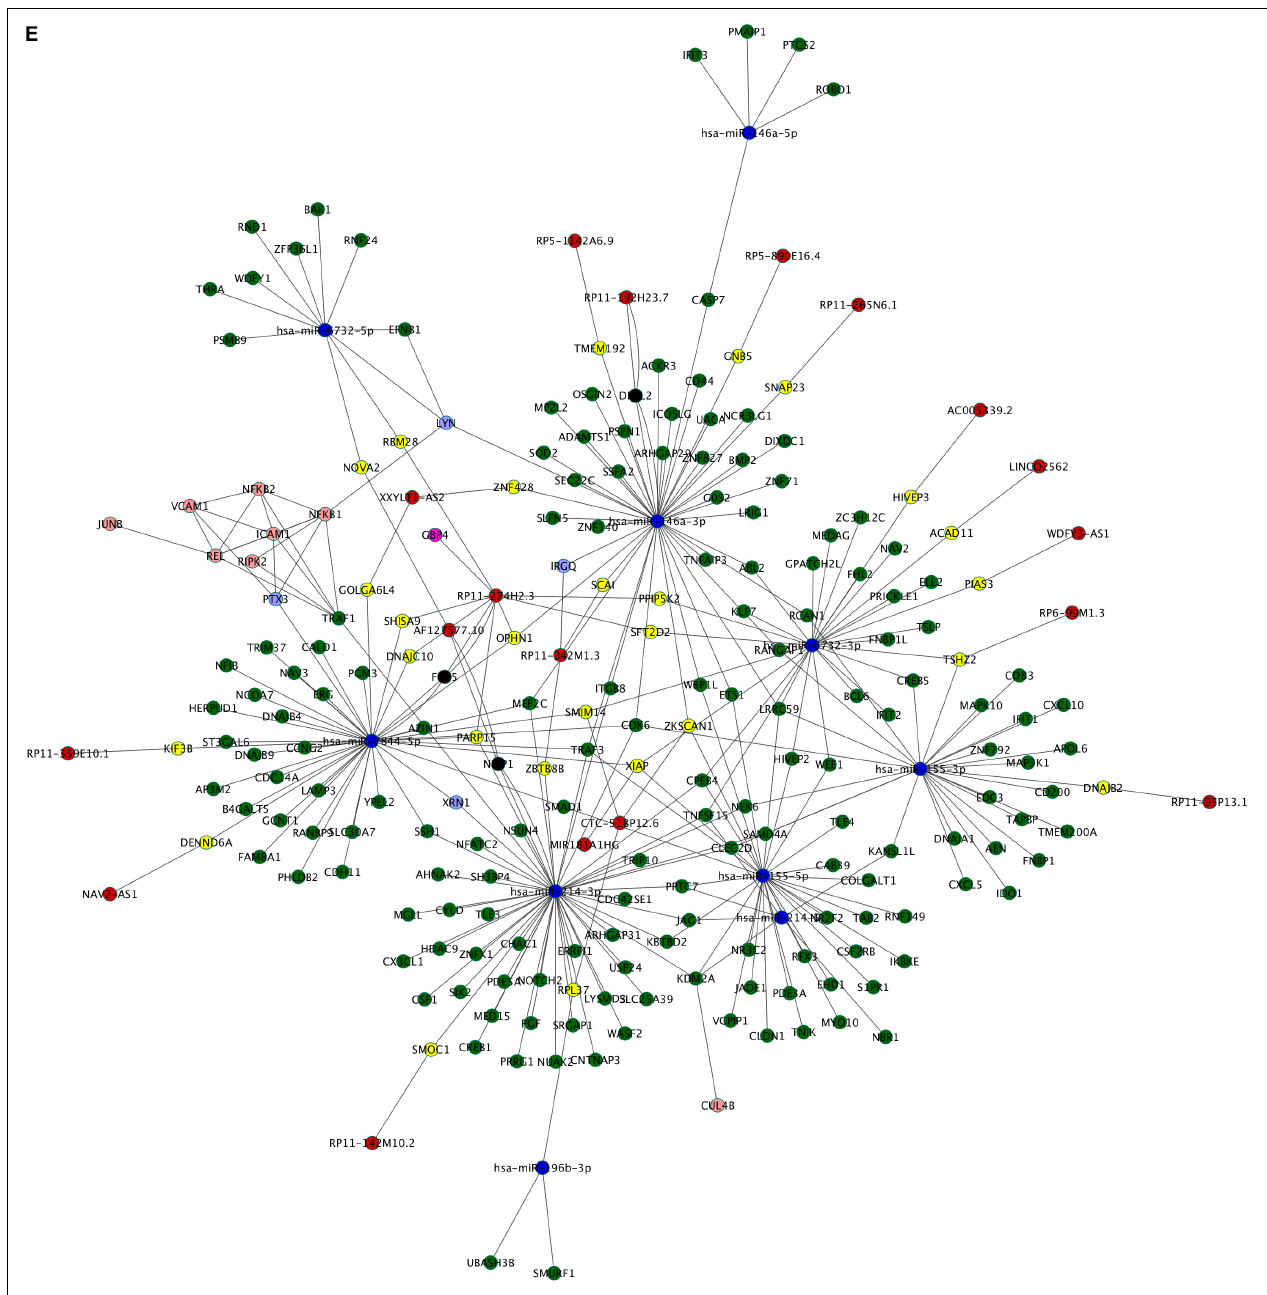
FIGURE 1 | TNF- α modulates the expression of mRNAs, miRNAs, lncRNAs, and proteins in human brain microvascular endothelial cells. HBMEC cells induced under stress by 4 h-incubation with TNF- α were used in microarray analysis and proteomic analysis to determine the differential expression of transcripts and proteins between groups. (A) Manhattan plot of total transcripts, 983 transcripts positioned above the line were considered differentially expressed. (B) Histogram of the number of differentially expressed mRNAs, miRNAs, lncRNAs, and proteins. (C) Venn diagram to indicate the relationships between the number of mRNAs, miRNAs targets, lncRNA targets, and proteins differentially expressed. (D) Global network of interactions modulated by TNF- α treatment in HBMEC cells. The total interactions between mRNAs, miRNAs and targets, lncRNAs and targets and protein-protein interactions were used to build a network with Cytoscape software. Nodes colored labels. Red-lncRNAs, blue marine-miRNAs, green-miRNAs targets and mRNAs DE, pink-lncRNA targets and mRNA DE, yellow-lncRNA and miRNA targets and mRNA no DE, purple-mRNAs DE, melon-proteins and mRNA DE, clear purple -proteins and mRNAs DE and regulated by miRNAs or lncRNAs, blue clair-proteins, and mRNAs no DE. DE, differentially expressed. (E) Zoom network of interactions between the components of each omic layer and also corresponding to differentially expressed mRNAs. Nodes colored labels. Red-lncRNAs, blue marine-miRNAs, green-miRNA targets, pink-lncRNA targets, yellow-lncRNA, and miRNA targets, melon-proteins, clear purple-proteins regulated by miRNAs, and lncRNAs.